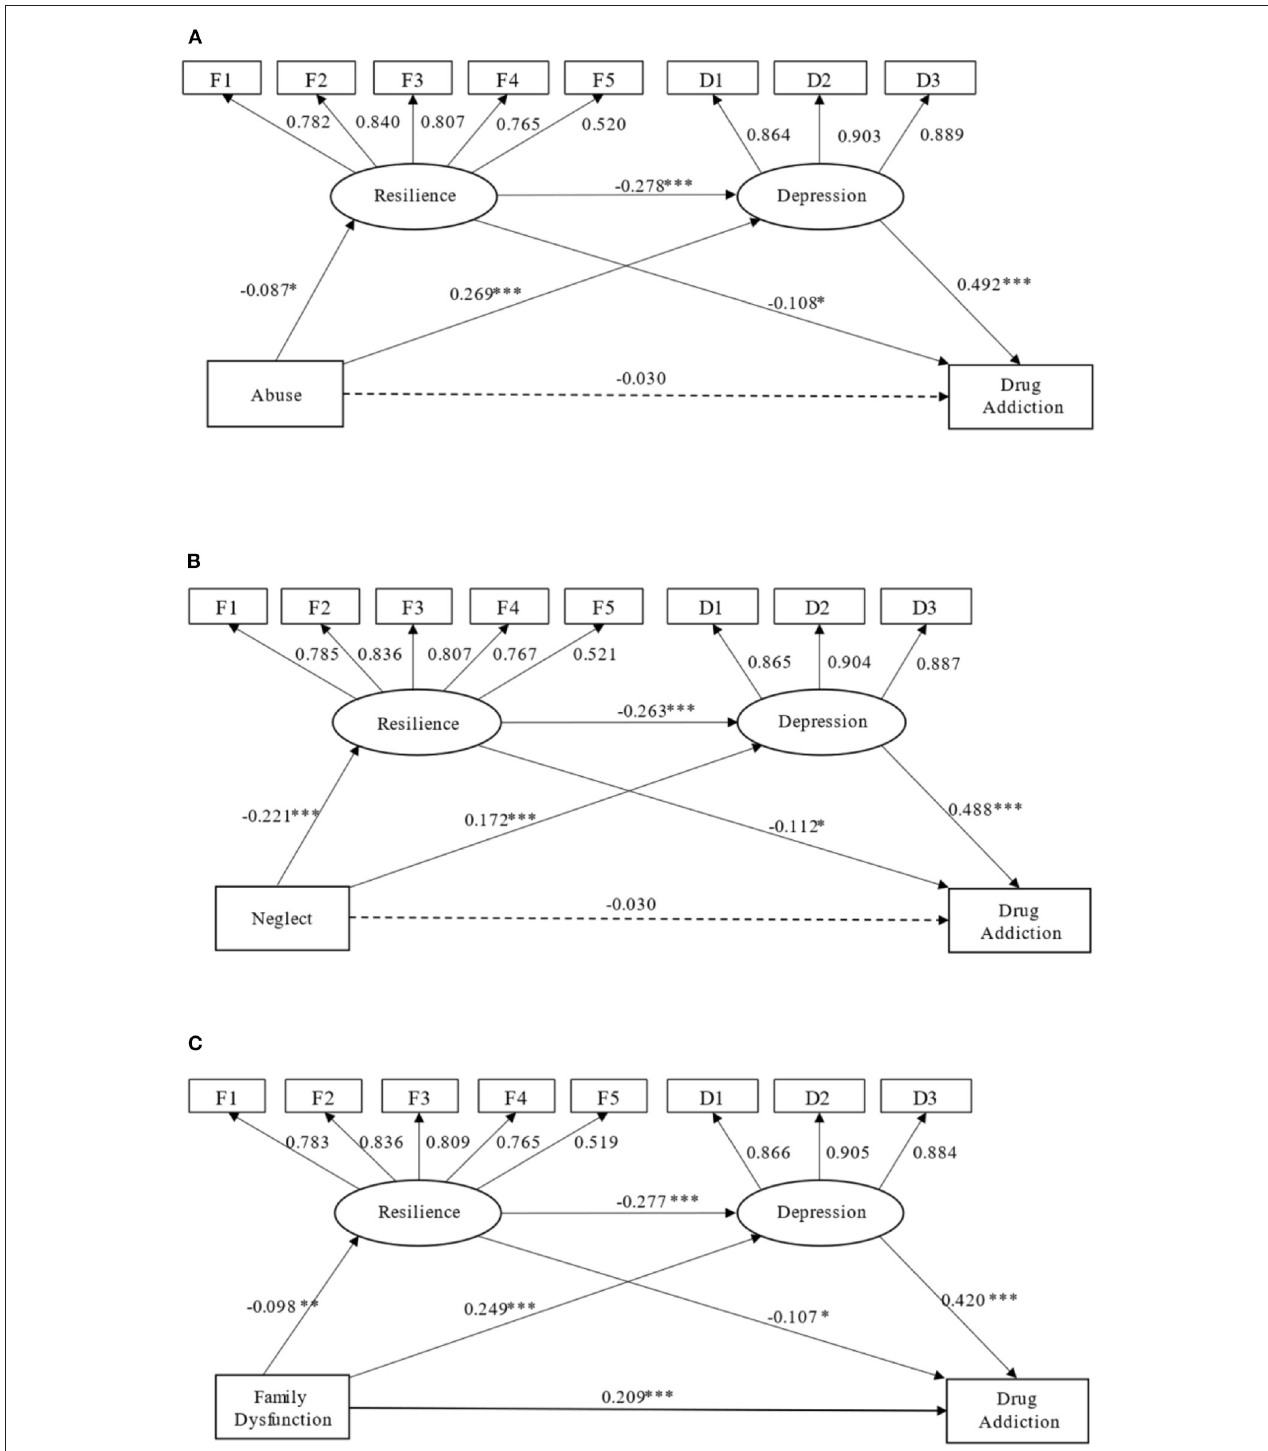
FIGURE 4 | (A–C) Serial mediation models (Models 4–6) were established with different subcategories of ACEs (childhood abuse, childhood neglect, family dysfunction) as their respective predictors. Path coefficients are standardized. * p < 0.05, ** p < 0.01, *** p < 0.001.